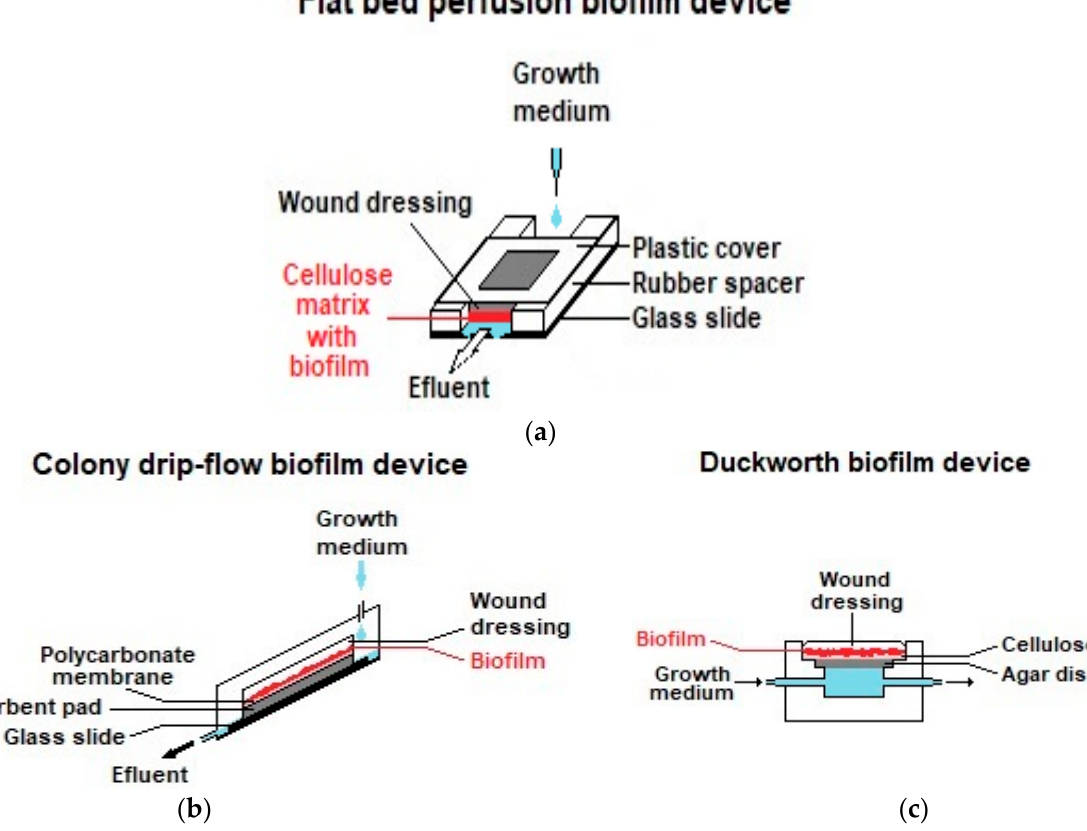
Figure 7. Schematic representation of in vitro dynamic biofilm models employed in the evaluation of the antibacterial activity of AMDs. ( a ) The flatbed perfusion biofilm model is composed of a cellulose matrix that contains a biofilm held on an inclined glass slide. Growth media are perfused through the cellulose matrix and collected for bacterial quantification. ( b ) The colony drip-flow biofilm model is composed of a semipermeable polycarbonate membrane in which biofilms are grown, which is placed on an absorbent pad sitting on an inclined glass slide. Growth medium is dripped on the microscope slide, perfusing the absorbent pad. ( c ) The Duckworth biofilm device is a flow device that contains wells with an agar disk fed with flowing growth medium from beneath, on top of which semipermeable cellulose-based disks can be placed and inoculated for biofilm growth. AMDs are assayed by direct application on the